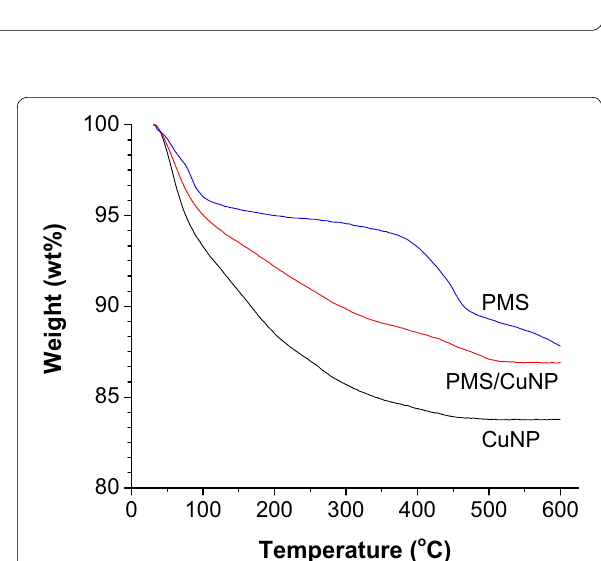
Fig. 2 TEM graphs of CuNP ( a ) and PMS/CuNP ( b )